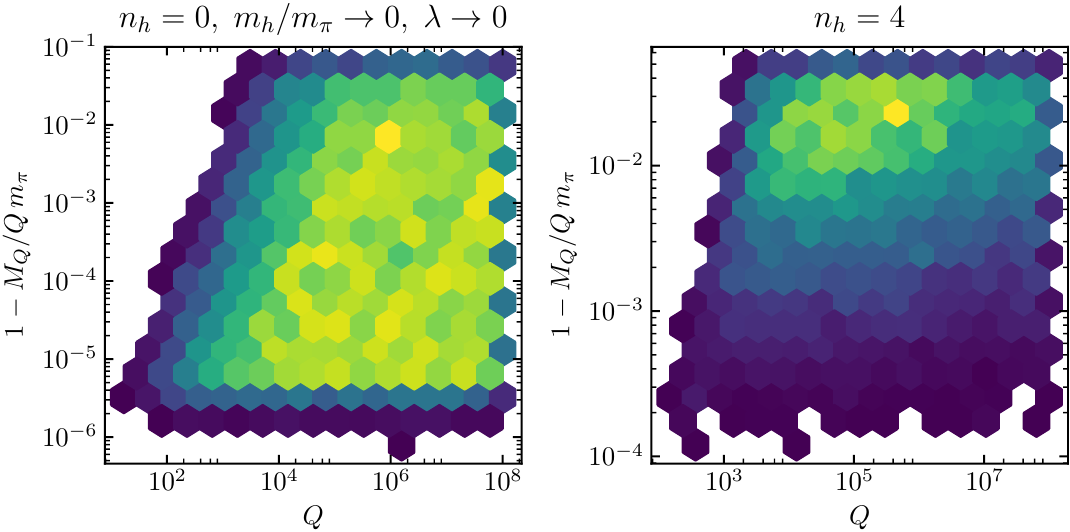
Figure 3 . Number of Q-ball solutions with di(cid:11)erent fractional binding energies for di(cid:11)erent choices of Q-ball charge. The shade of a given cell corresponds to the number of solutions in that cell; a lighter (more yellow) shade corresponds to more solutions. The left and right panels show the result of the scan for the minimal case and the full case